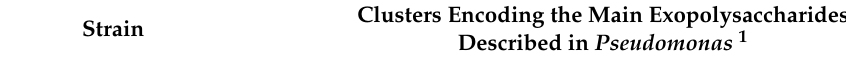
Table 1. Main exopolysaccharides produced by different Pseudomonas spp. strains that are involved in biofilm